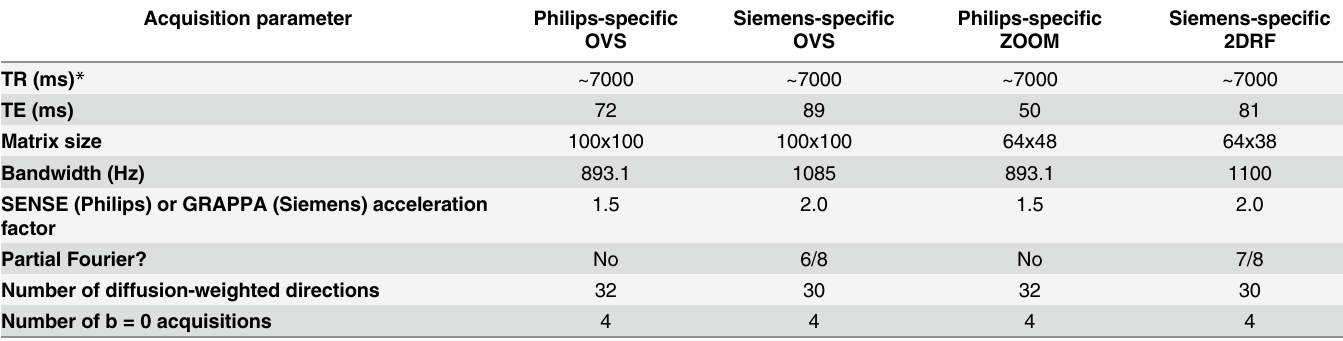
Table 1. Manufacturer-specific acquisition